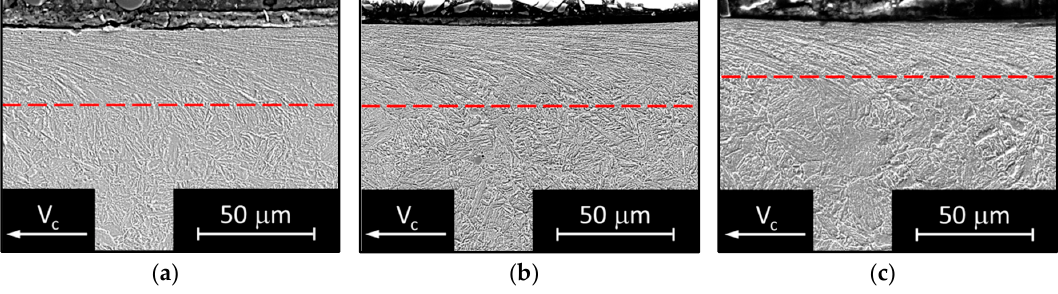
Figure 7. Scanning electron micrographs of S110 specimen with a feed rate of ( a ) 0.05 mm; ( b ) 0.10 mm; ( c ) 0.15 mm.